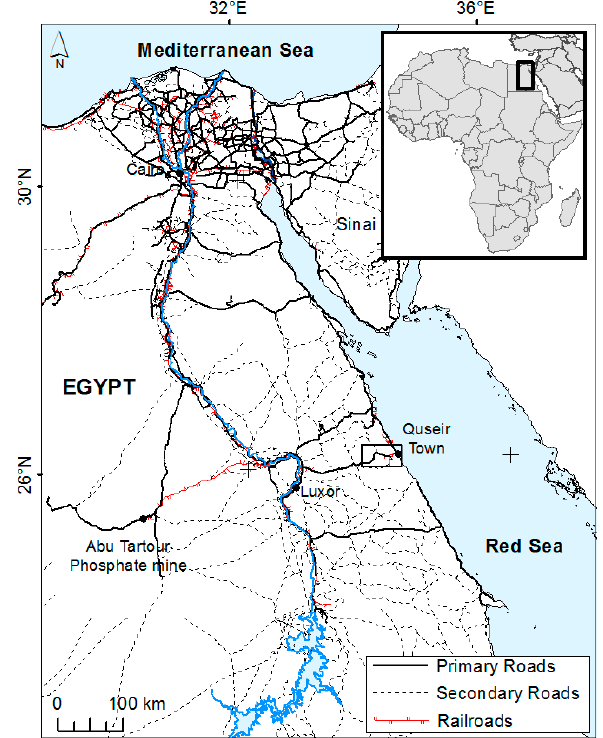
Figure 1. Map of the study region. Rectangular box indicates the study area of Wadi El-Ambagi on the Red Sea coast.